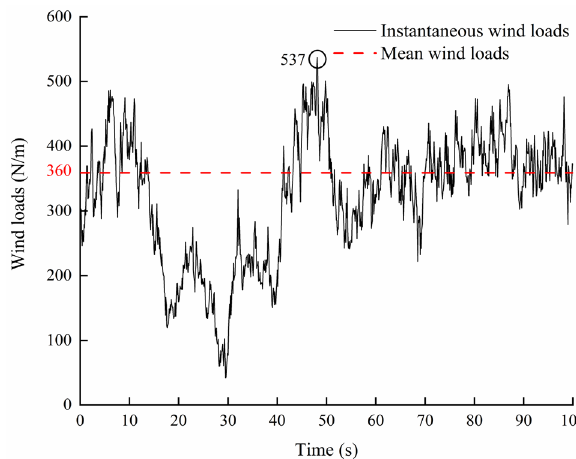
Figure 5. Wind loads acting on greenhouse.